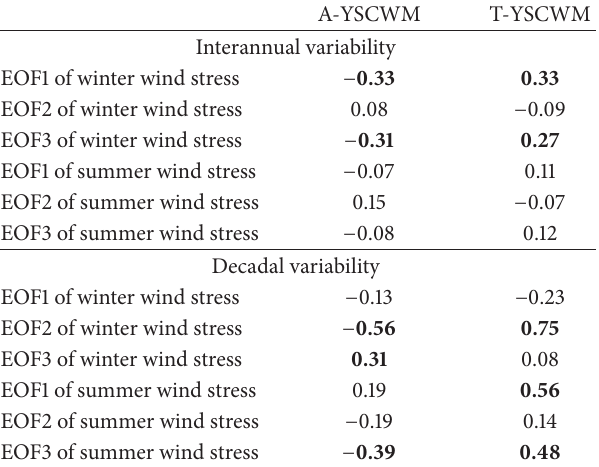
Table 3: Correlation coefficients between EOF1, EOF2, and EOF3 of wind stress and A-YSCWM, T-YSCWM in August, including the interannual and decadal components in both summer and winter. Bold texts indicate that the correlations are statistically significant at the 95% confidence